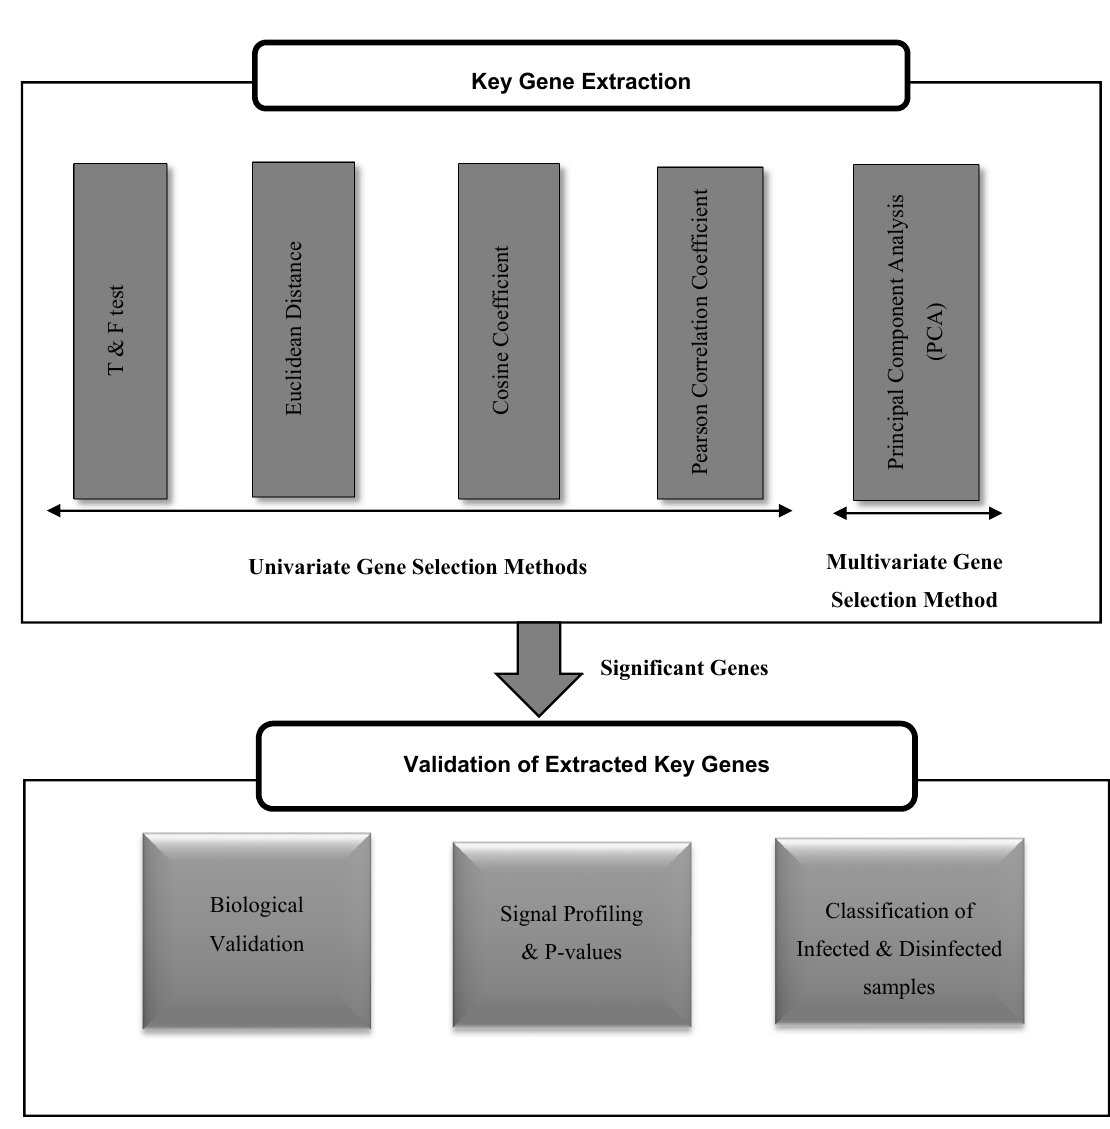
Figure 1. The proposed framework for the extraction and validation of up / downregulated key genes for risky outcomes of hepatitis C virus (HCV).